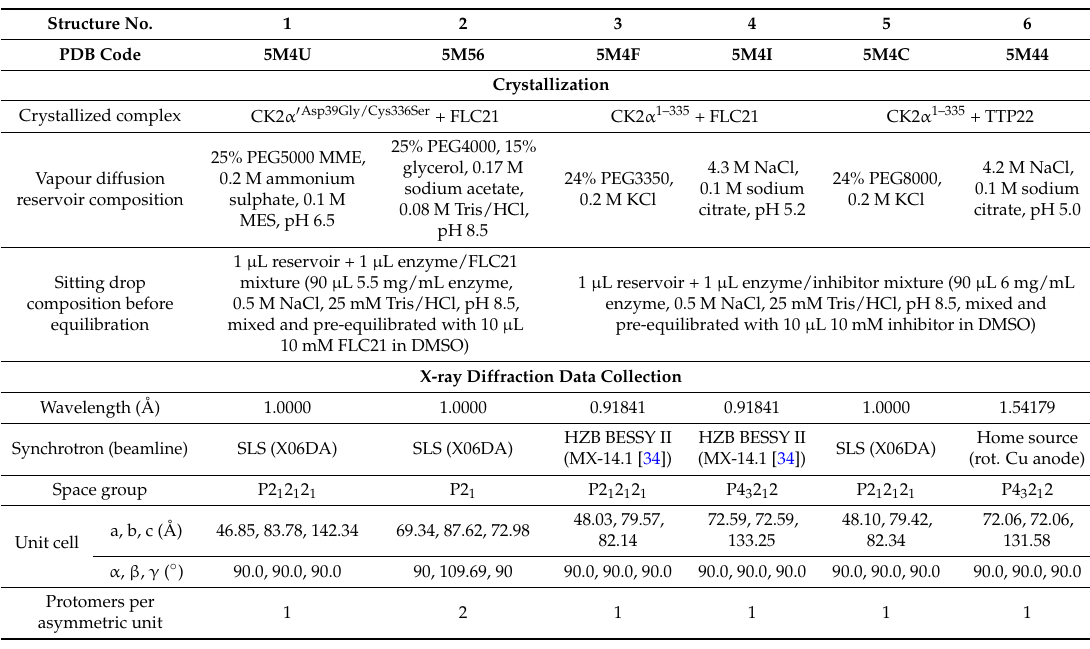
Table 1. Crystallization, X-ray diffraction data and refinement